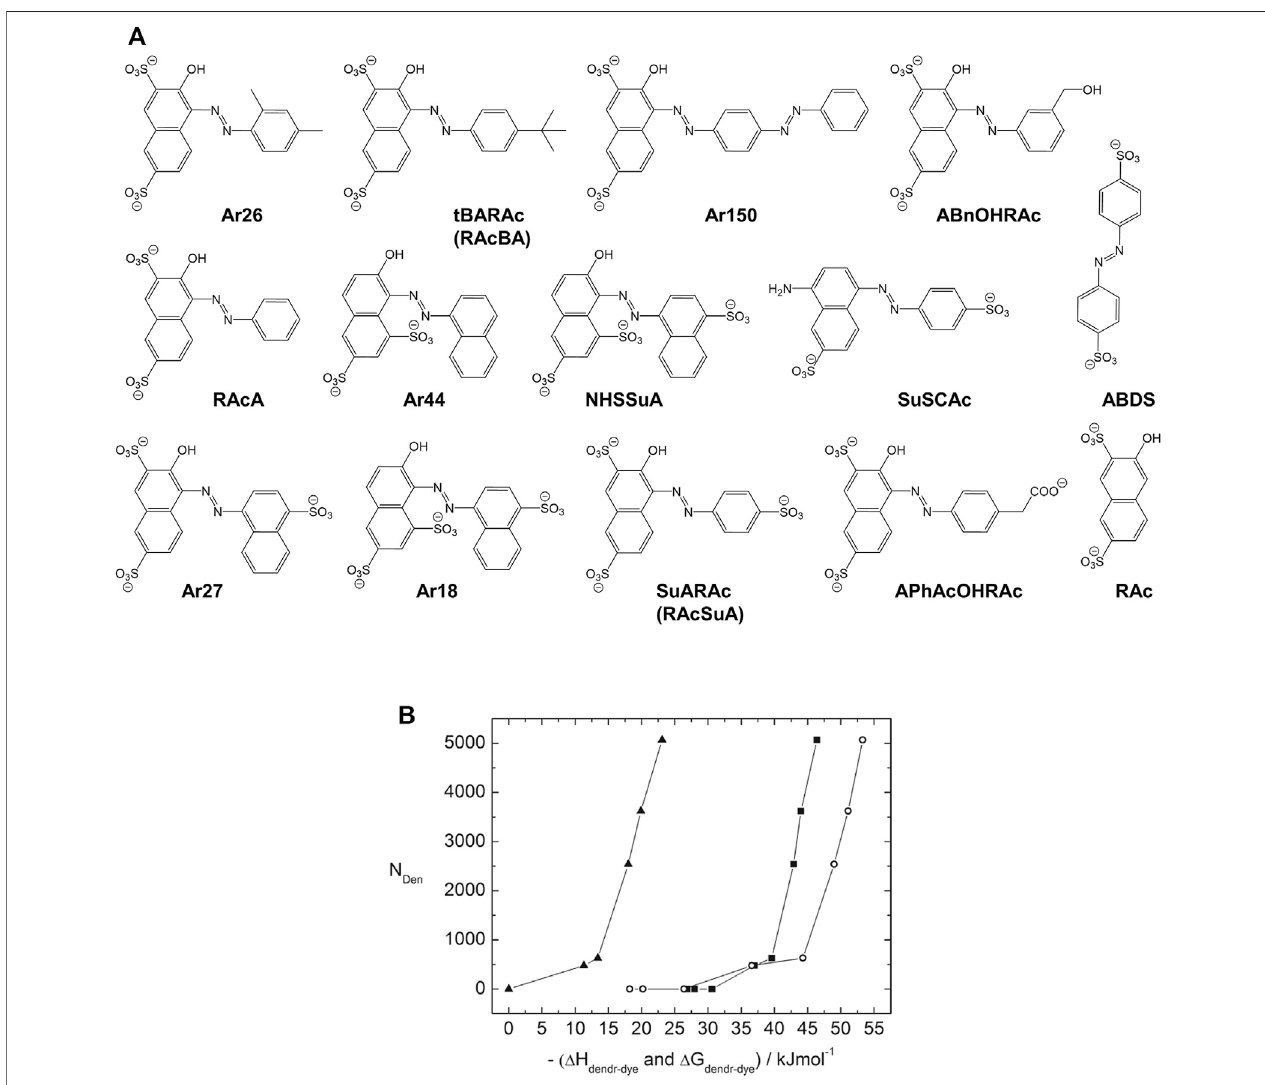
FIGURE 11 | Thermodynamic study of a dendrimer-dye model system for electrostatic self-assembly in solution, elucidating the nano-objects ’ size control: (A) Structural formulae of structurally related divalent and trivalent azo dyes; (B) Dendrimer aggregation number N Den in dependence on the dendrimer-dye interaction free energy Δ G dendrimer-dye ( squares ) anddendrimer-dyeinteractionenthalpy Δ H dendrimer-dye ( opencircles ) anddye-dyeinteractionfreeenergy Δ G dye_dye ( triangles ) fordivalent dyes (Willerich and Gröhn, 2011a). Reprinted with permission. Copyright © 2011 American Chemical Society.